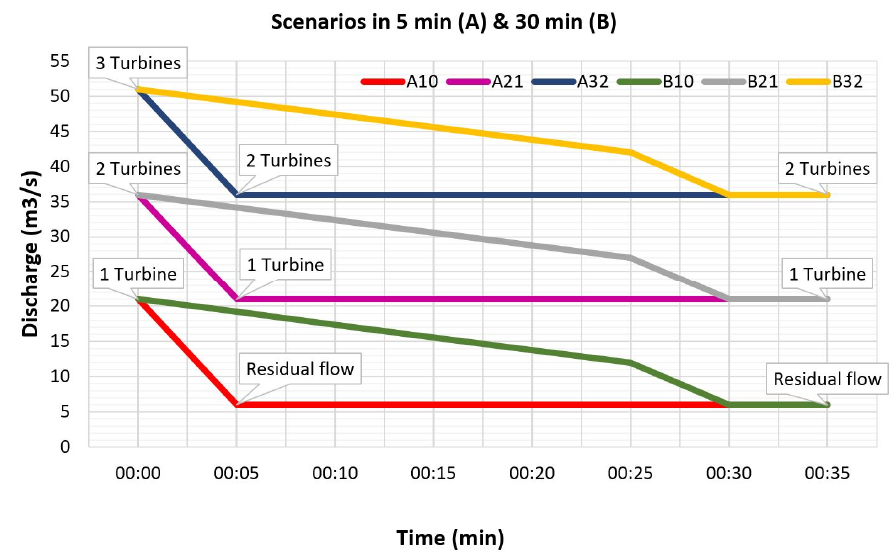
Figure 2. Dewatering scenarios for stranding risk modelling in Storåne River.